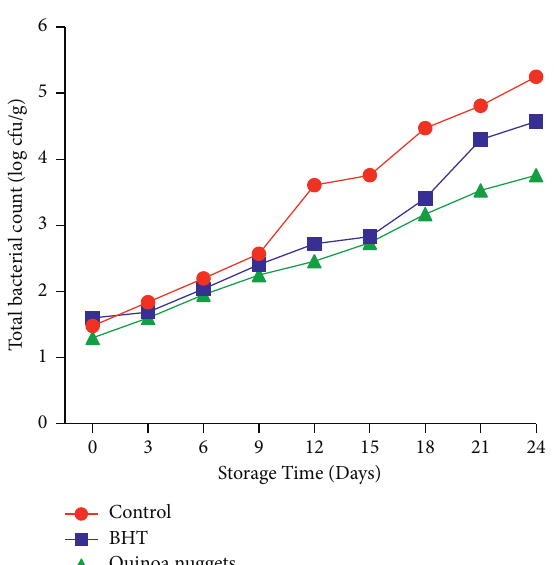
Figure 5: Total bacterial count (log cfu/g) of chicken nugget samples during storage at 4 ° C for 24